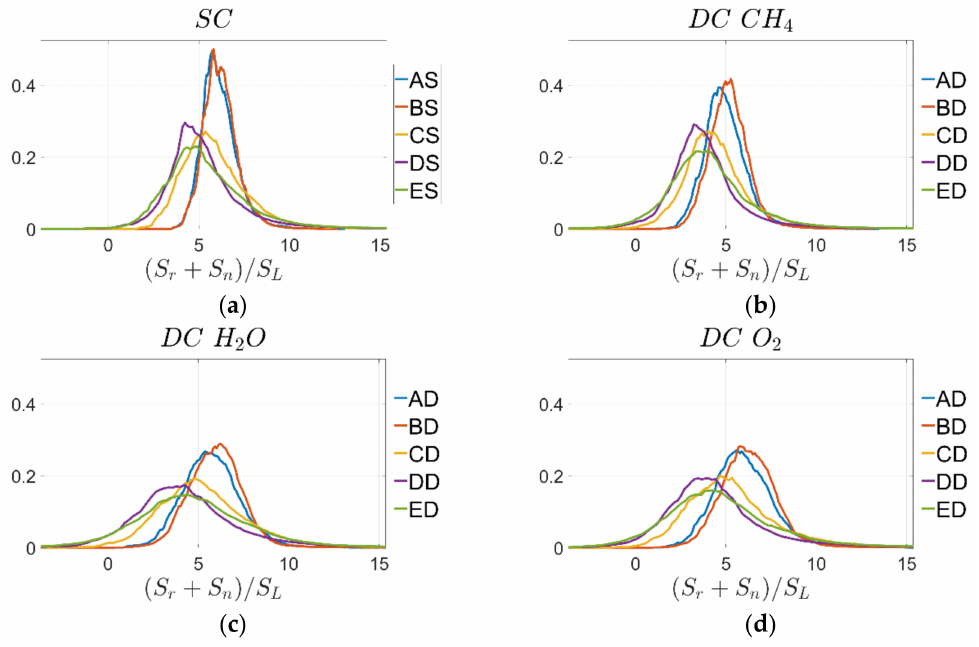
Figure 7. PDF of normalised, combined reaction and normal diffusion components of displacement speed ( S r + S n ) / S L on c = 0.8 progress-variable isosurface for cases A–E for ( a ) SC and ( b – d ) DC simulations for reaction progress variable based on CH 4 , H 2 O,O 2 mass